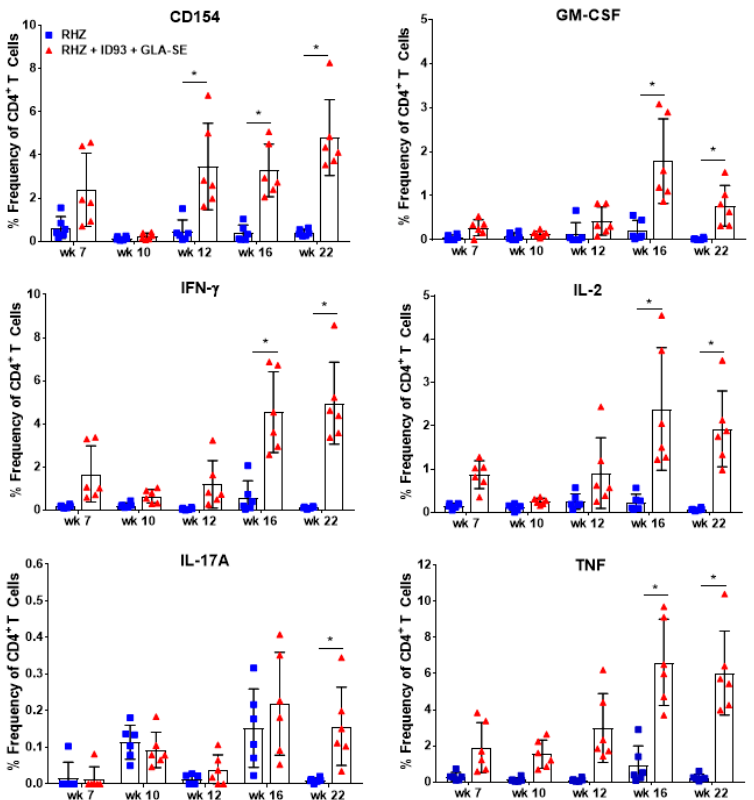
Figure 2. Cytokine production from ID93 antigen-specific CD4 + T cells over time. Percent frequency of CD4 + T cells expressing CD154, GM-CSF, IFN- γ , IL-2, IL-17A, and TNF cytokines after restimulation with ID93 antigen in samples collected in RHZ only (blue, squares) treated and RHZ+ID93/GLA-SE (red, triangles) treated cohorts over time. Significant differences between cohorts was determined by two-way ANOVA with Sidak’s multiple comparison test. The asterisk denotes significance where p < 0.05. Six mice/group/timepoint were included and data are representative of two independent experiments.